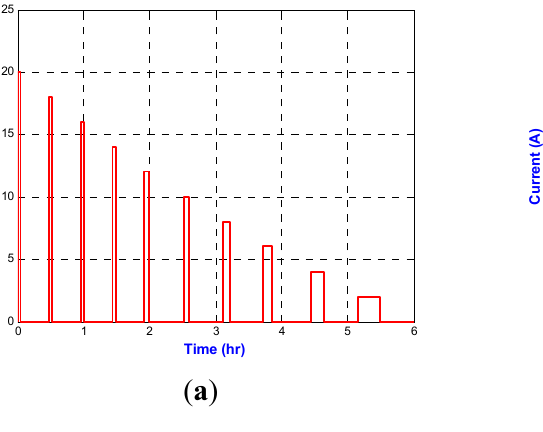
Figure 7. Current profiles in experiment II. ( a ) Discharge; ( b )